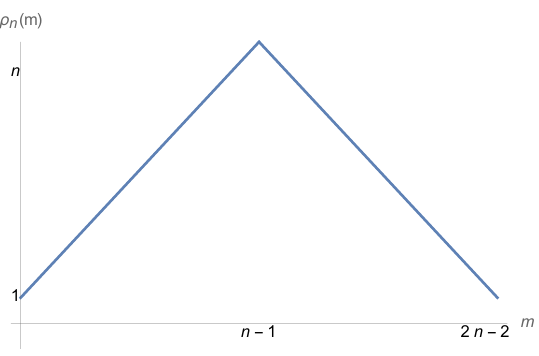
Figure 6 . The spectral weights (4.4) follow a ‘triangle